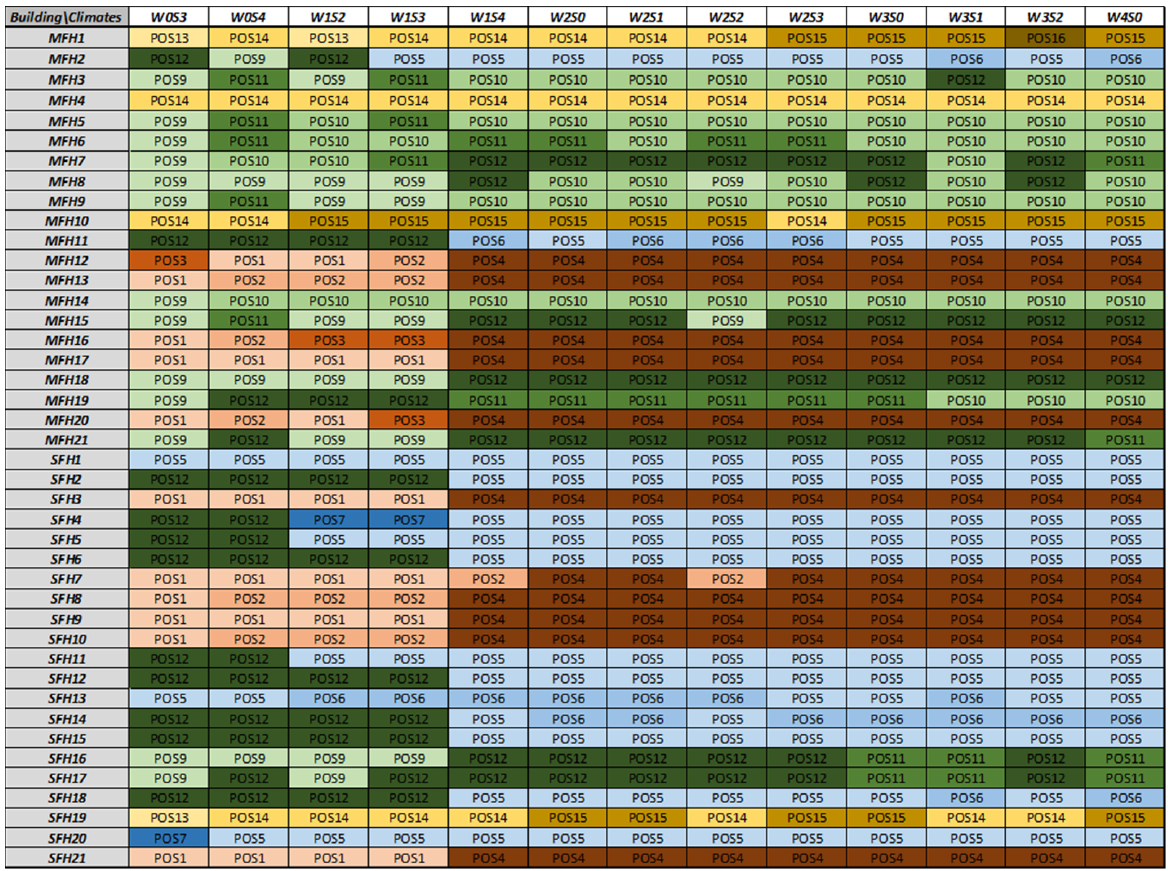
Figure 1. Full set of Packages of Optimal Solutions.